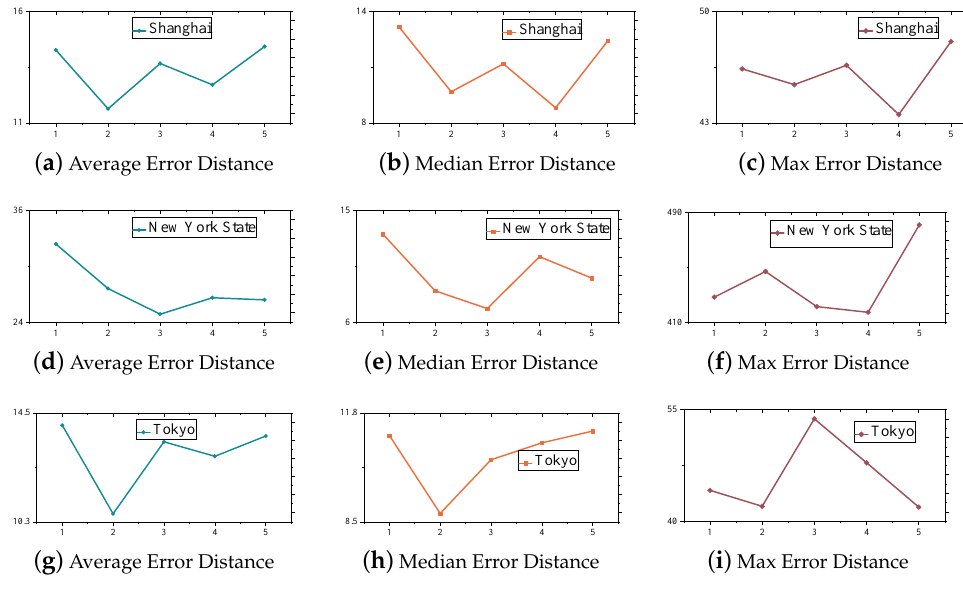
Figure 7. Study of hidden layers in the three